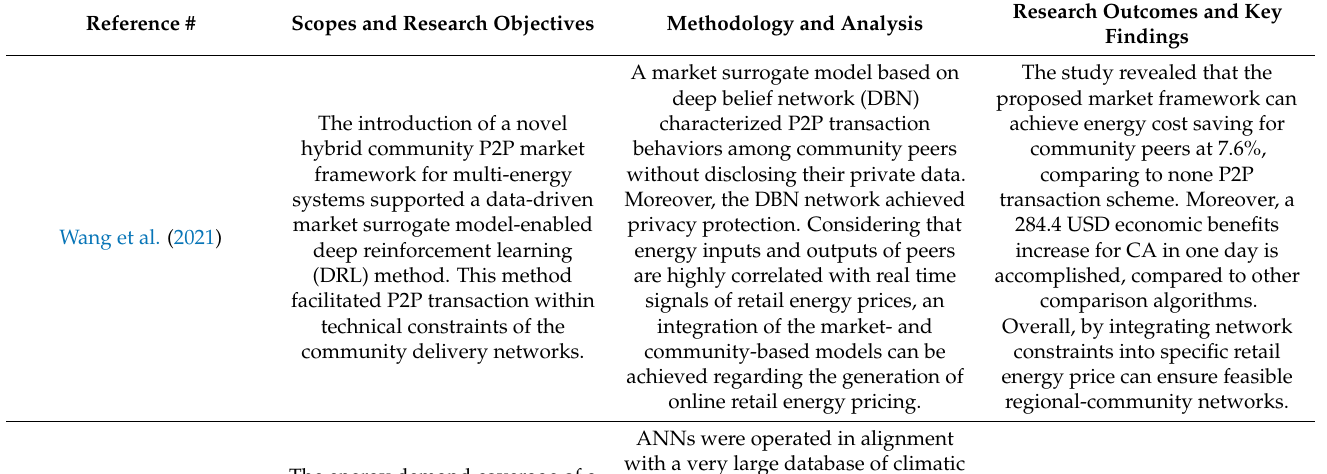
Table 6. The context of ANNs (including networks security)—Group 1 (studies are presented in reverse chronological order and in last name of first author alphabetical